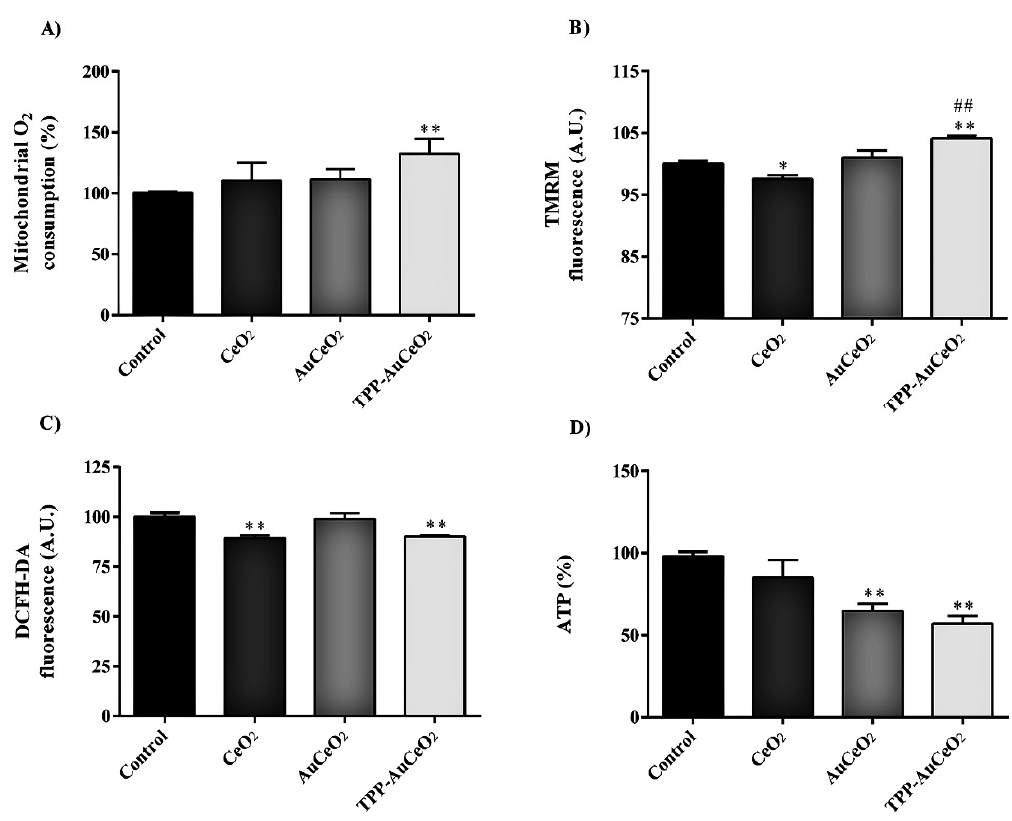
Figure 5. Physiological parameters associated with mitochondrial function. ( A ) Mitochondrial O 2 consumption of HeLa cells measured in a Clark-type O 2 electrode, ( B ) ∆Ψ m measured with the TMRM probe, ( C ) cellular ROS content measured with the DCFH-DA probe, and ( D ) ATP content measured with the luciferase method after 24 h of treatment with vehicle (control) or CeO 2 , AuCeO 2 , and TPP–AuCeO 2 at 20 µ g / mL. Data are presented as mean ± SEM * p < 0.05 versus control group 24 h; ** p < 0.01 versus control group 24 h. ## p < 0.01 versus CeO 2 .